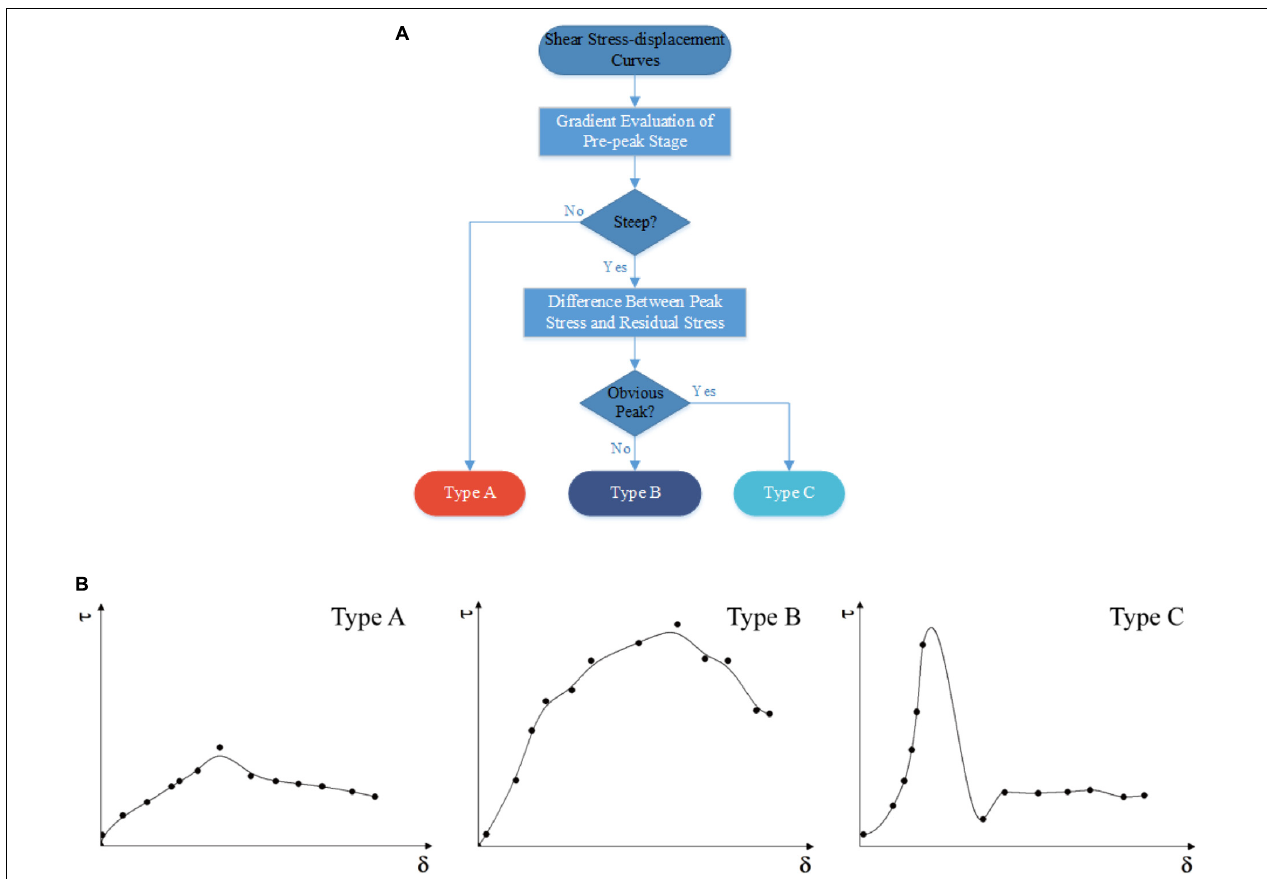
FIGURE 11 | Classification of the shear stress–displacement curves. (A) Process for determining the type of curve. (B) Three types of the shear stress–displacement curve.